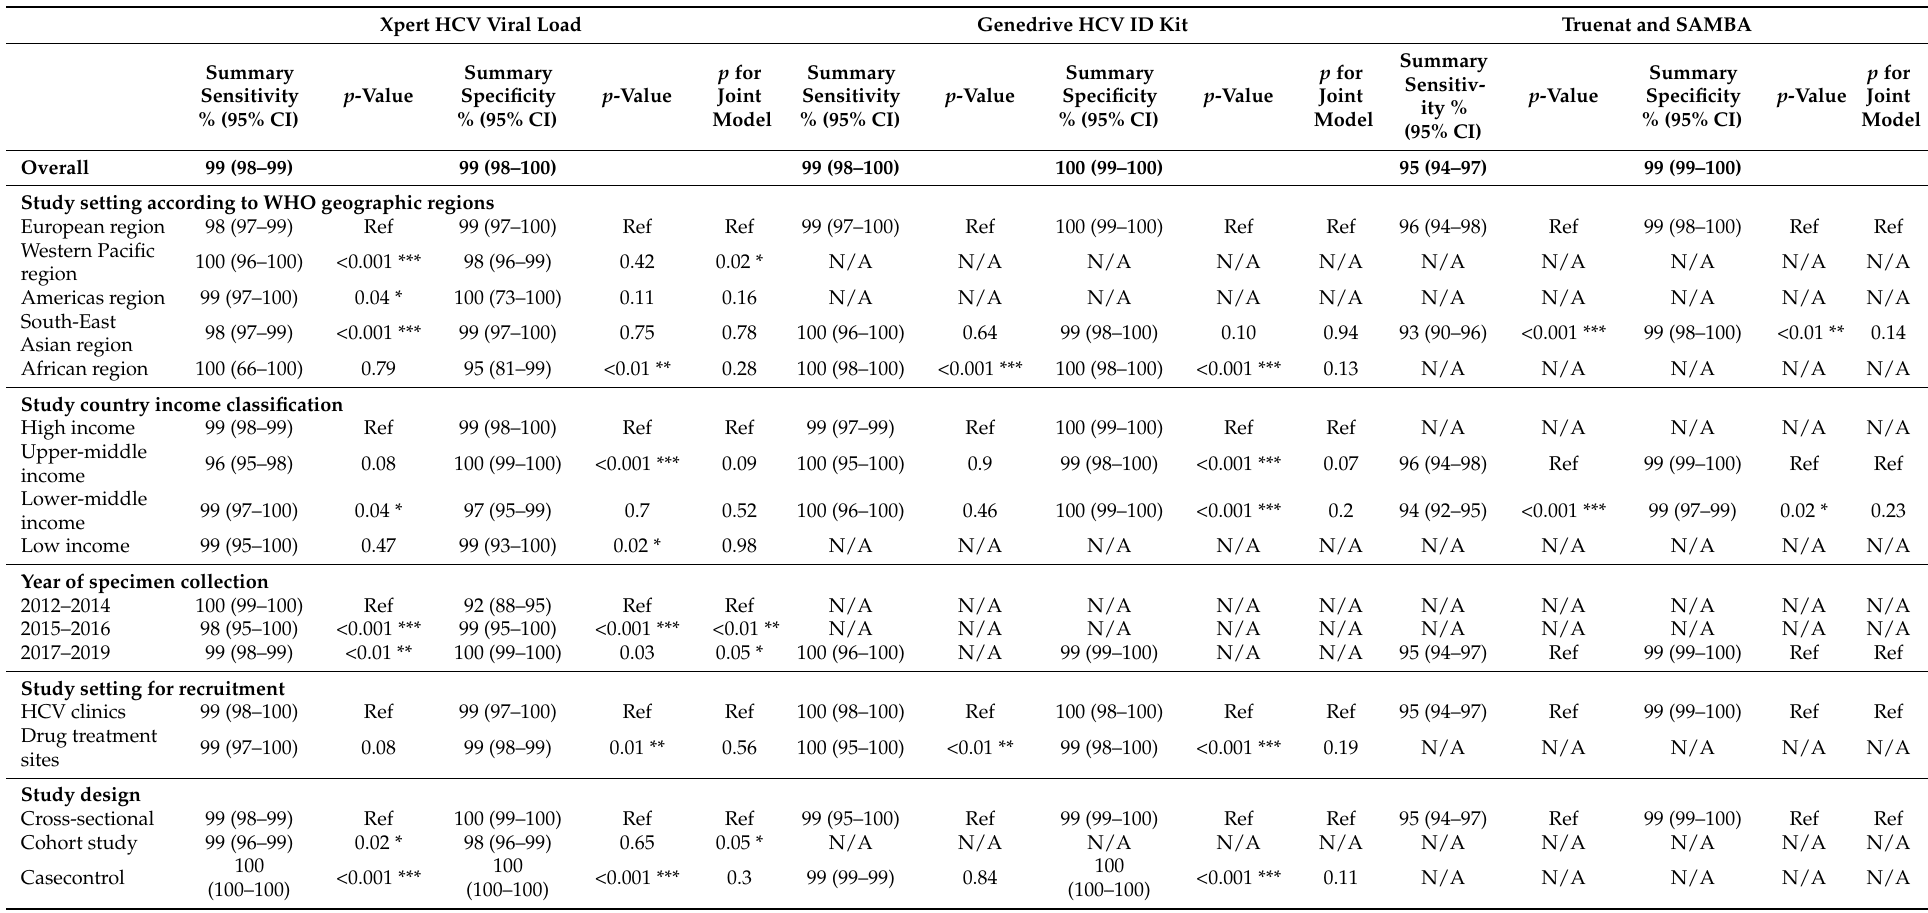
Table 2. Diagnostic accuracy of point-of-care HCV RNA assays for diagnosing and monitoring chronic HCV infection in sub-group and meta-regression